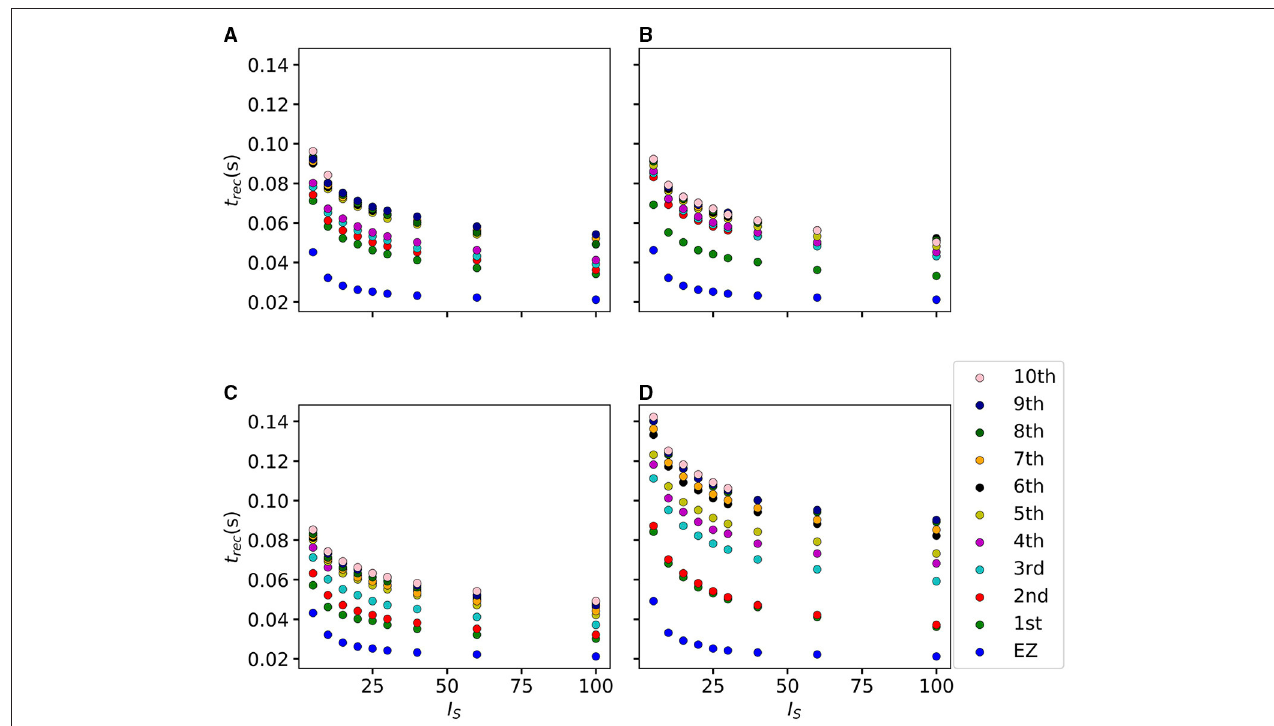
FIGURE 15 | Recruitment times of the first 10 recruited areas as a function of the input current I S for the epileptic patients (A) E2, (B) E3, (C) E6, and (D) E13. The strength of the input current is varied between 0 and 100 on the x -axis, while its duration is kept unchanged at t I experiments. The order of the recruitment is color-coded for each current strength (i.e., blue dots indicate the recruitment of the EZ, green dots indicate the first recruited area, red the second, etc.), and it holds the same for all investigated patients. Parameters as in Figure 10